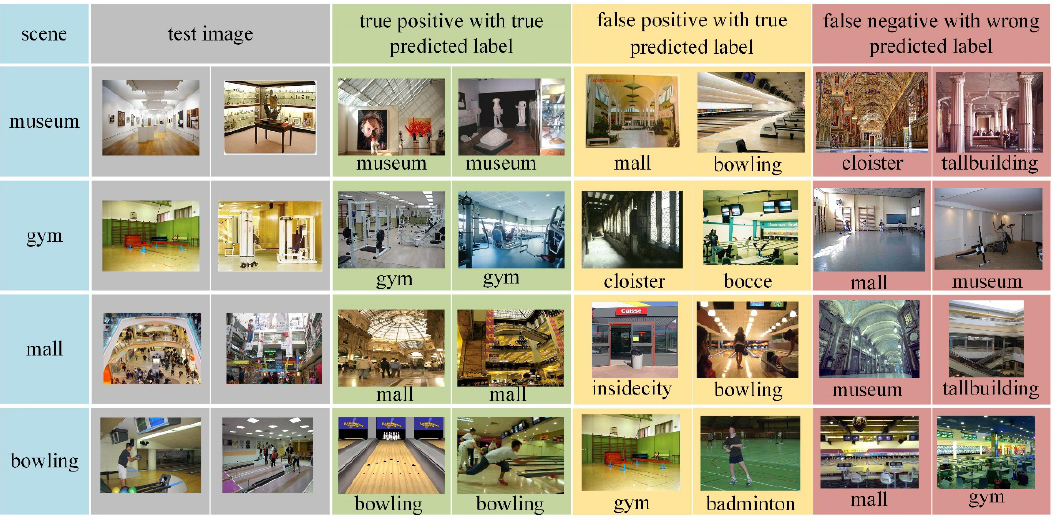
Figure 11. Visual table in from combined datasets.